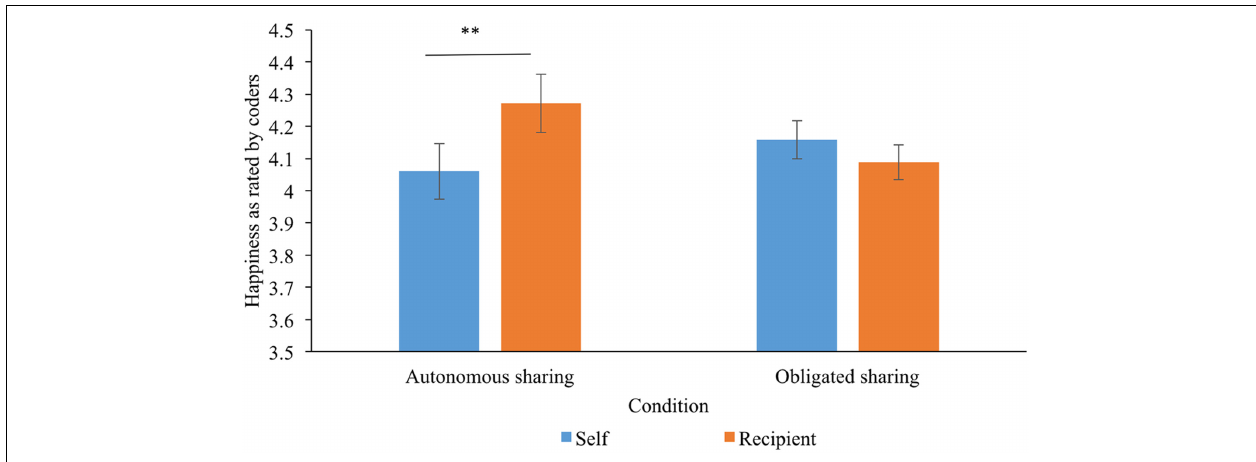
FIGURE 1 | Generous children’s happiness rated by coders when putting stickers into their own and the recipient’s envelope in two conditions. Error bars represent the standard errors of the means. ∗∗ p <